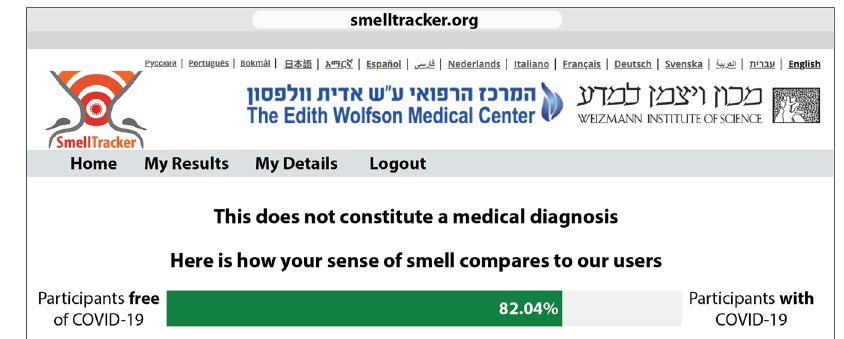
Fig. 6 Implementation through informative feedback. At the end of a ~5 min interaction, participants are informed as to what extent their sense of smell resembles a C19 + or C19 − participant. The above depiction is an anecdotal actual case of an individual who was C19 + , but completely subjectively unaware of any olfactory loss or impairment. Nevertheless, based on the olfactory perceptual fi ngerprint (OPF), our algorithm determined that this individual was 82.04% C19 + . This implies a useful implementation of